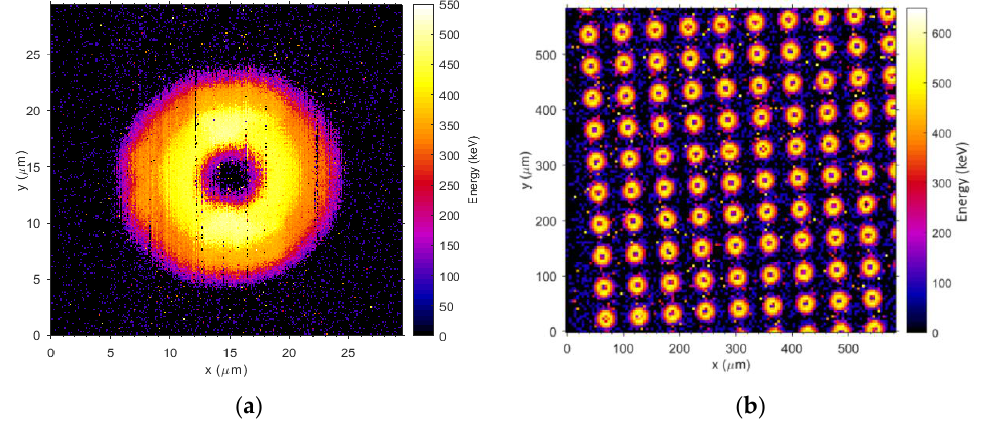
Figure 8. Charge collection median energy map of the 2µm-thick Mushroom- p microdosimeter at 10V bias for ( a ) a single SV and ( b ) an array of SVs.